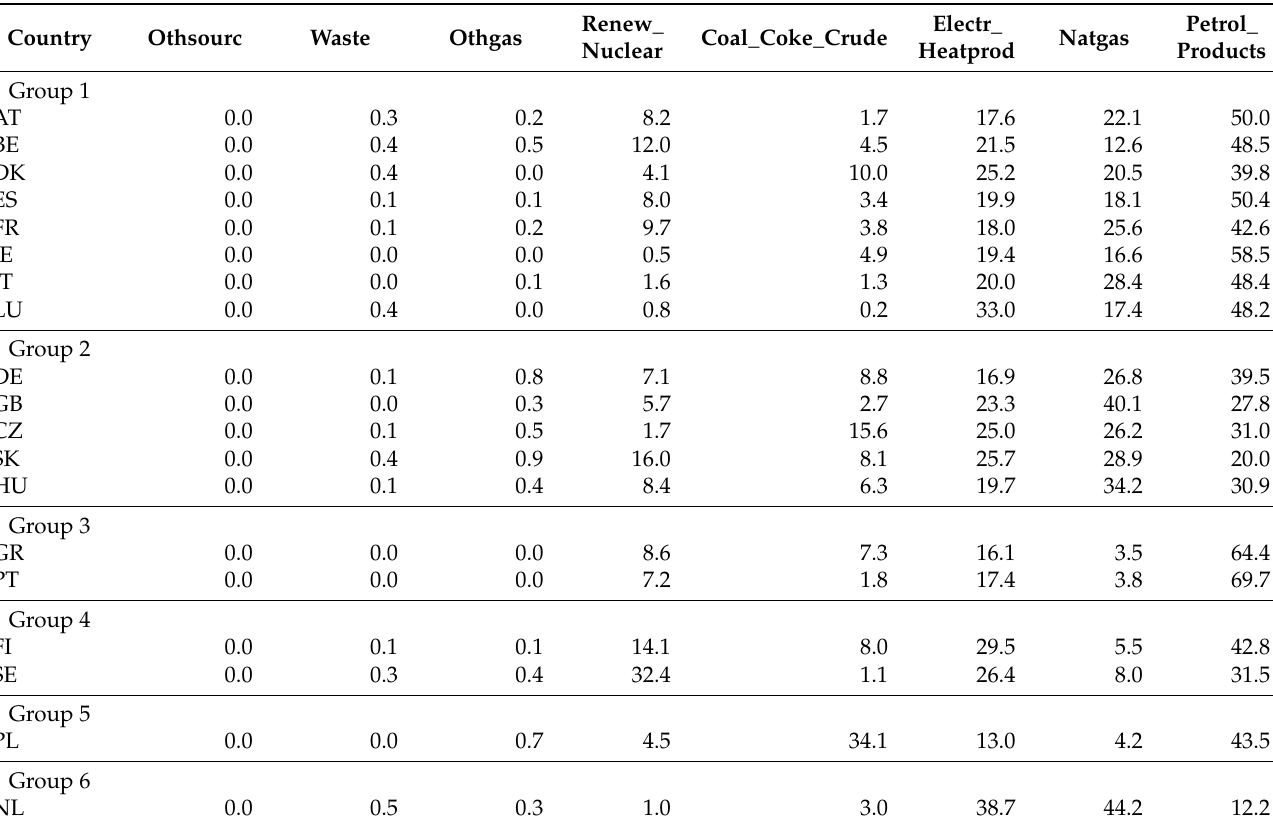
Table 1. Structures of energy use (%) in the food production systems in 2000–2001 ( γ =